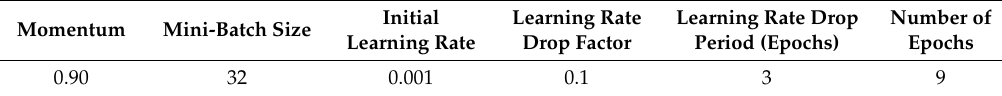
Table 3. Parameters for training CNN models in our